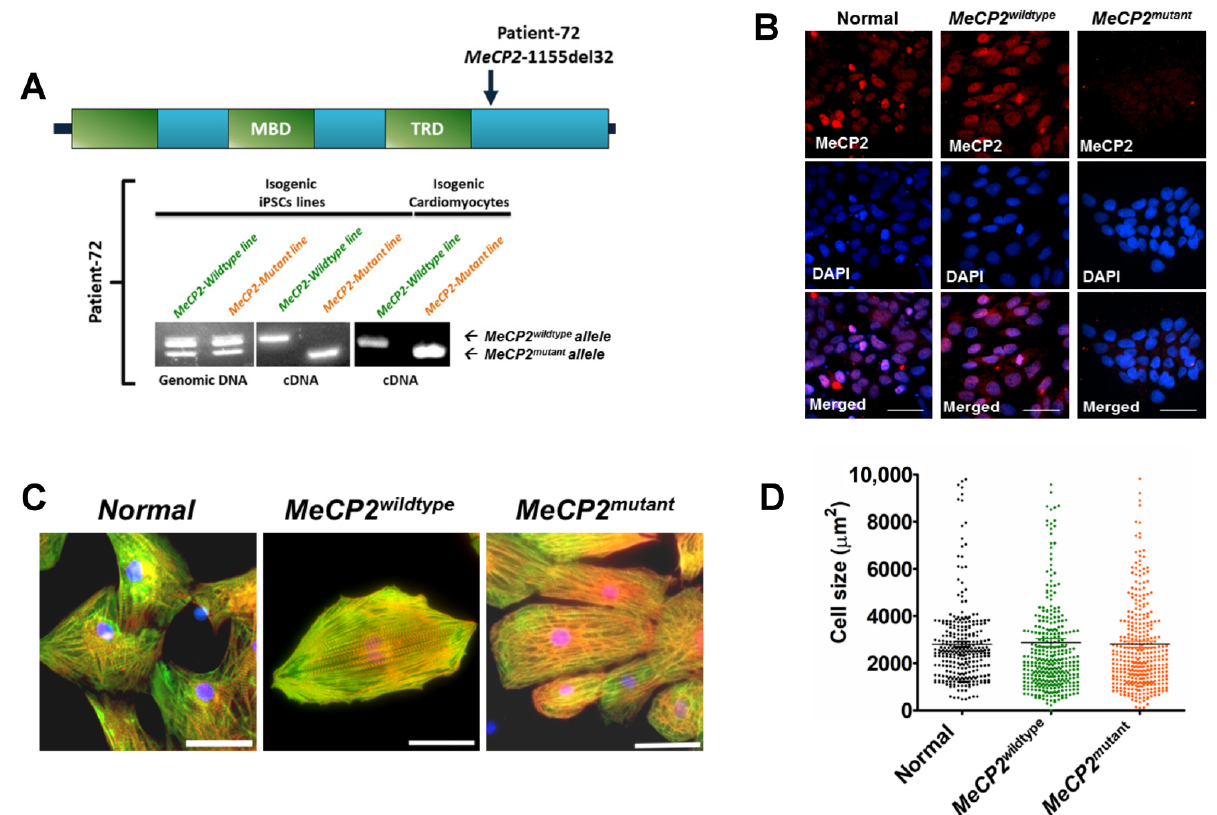
Figure 1. Generation of isogenic iPSC-derived cardiomyocytes expressing different MeCP2 alleles. ( A ) The MeCP2 mutation is indicated by the arrow head, and the expression of specific MeCP2 allele in the isogenic iPSCs was confirmed by PCR analysis. ( B ) Immunostaining analysis of the isogenic iPSCs with MECP2-specific antibody (ThermoFisher, Waltham, MA, USA, MA5-33096) indicated the nucleic localization of wildtype MECP2 protein. ( C ) The iPSC lines were differentiated into cardiomyocytes (iPSC-CMs) and co-stained with cardiac troponin T (green, Abcam, Cambridge, UK, ab45932) and sarcomeric α -actinin (red, sigma, A7811), and the nuclei were stained with DAPI (blue). ( D ) The cell size of the iPSC-CMs. N = 284, 357, and 360 cells measured from normal, MeCP2 wildtype , and MeCP2 mutant groups, respectively. Data are represented as mean ± SEM. Scale bar: 100 µm. (See also Figure S1).